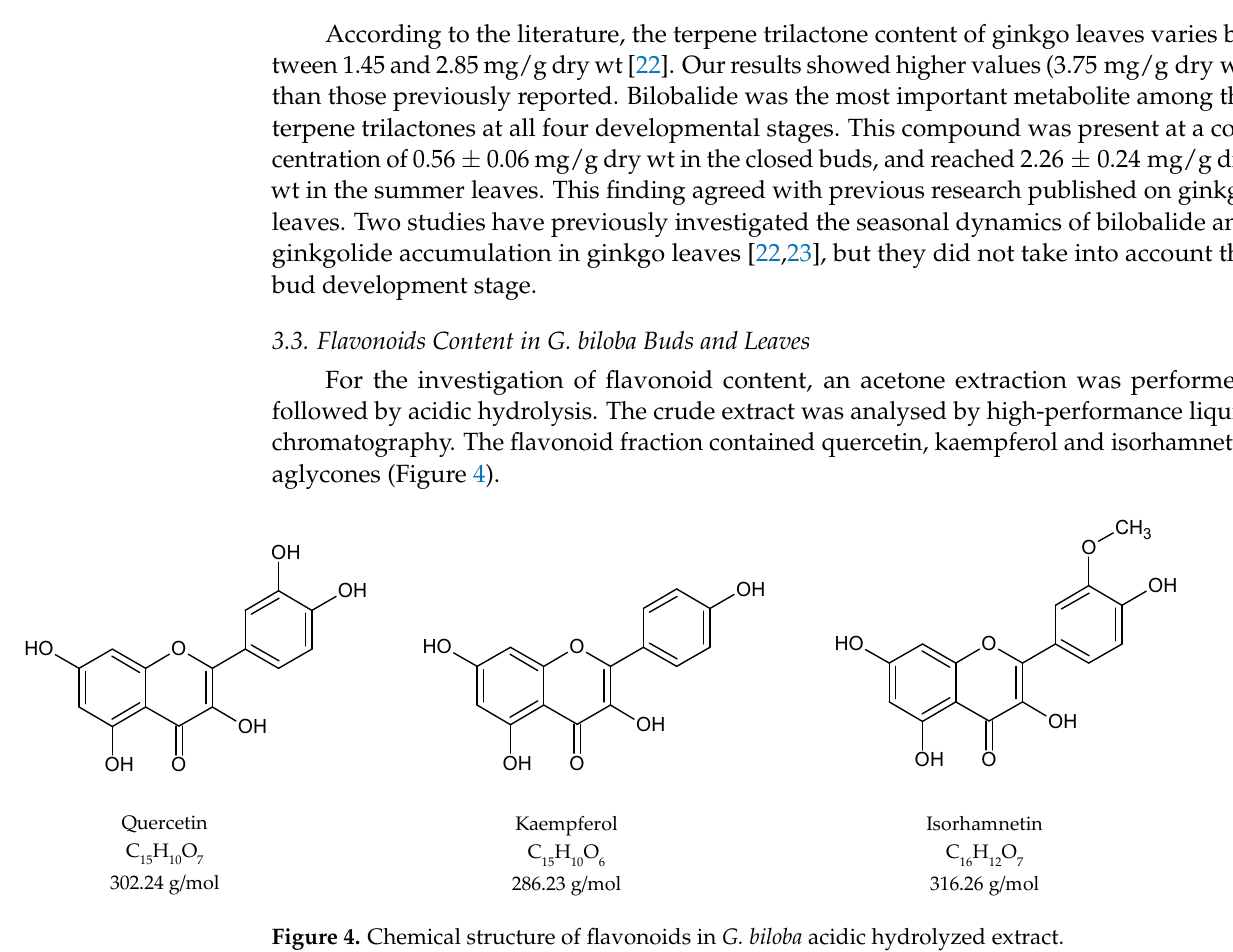
Figure 3. Terpene trilactone content (mg/g dry wt) of three physiological states of ginkgo buds and summer leaves. GA = Ginkgolide A, GB = Ginkgolide B, GC = Ginkgolide C, BB = bilobalibe. Data are given as mean ± SD, replicates are n = 3 and p < 0.001.